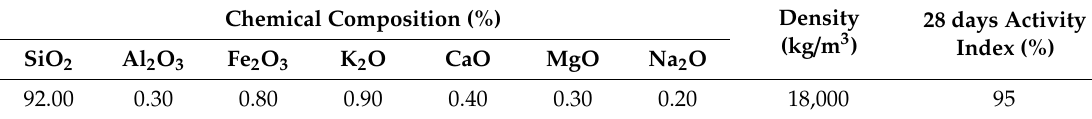
Table 2. The main performance indexes of